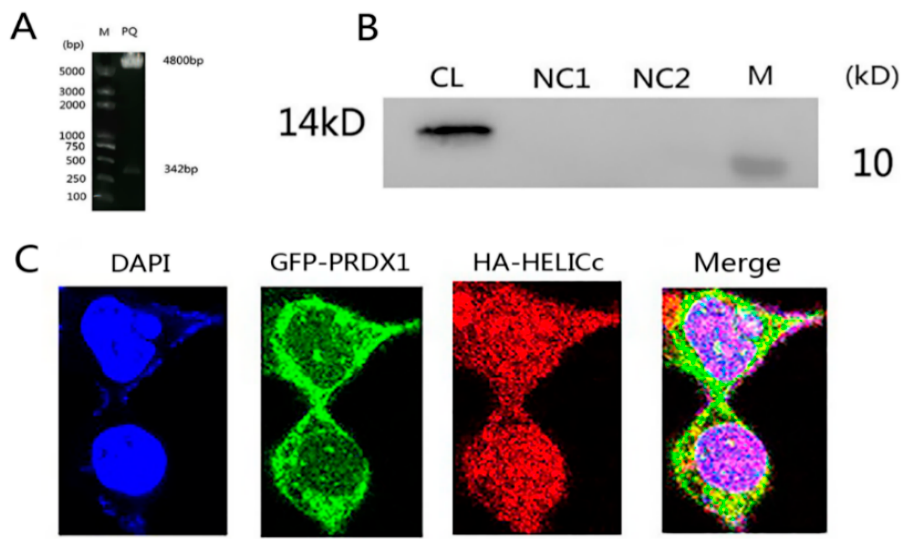
Figure 7. ( A ) Laser confocal intracellular co-localization of HELICc and PRDX1. Enzyme digestion of pCAGGS-HELICc. ( B ) Western blot analysis of HELICc. CL, lysate of HA-HELICc transformed cells; NC1 and NC2, protein of HA empty plasmid; M, protein marker. ( C ) Laser confocal observation. DAPI, nuclear location; GFP-PRDX1, PRDX1 cellular localization; HA-HELICc, HELICc cellular localization; Merge, PRDX1 and HELICc cellular